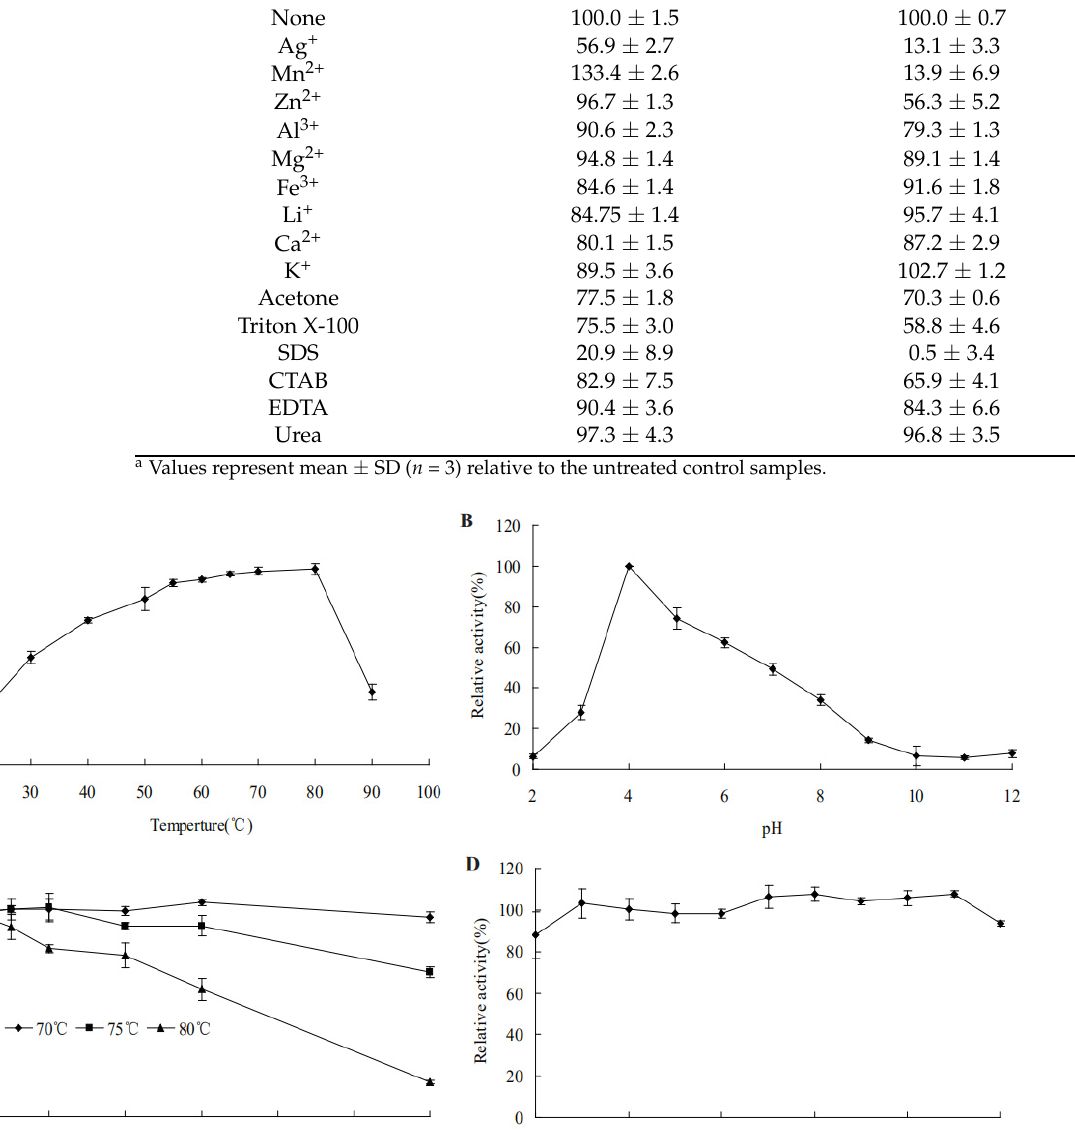
Table 2. Effect of various metal ions or chemical reagents on the activity of AfCel5A.